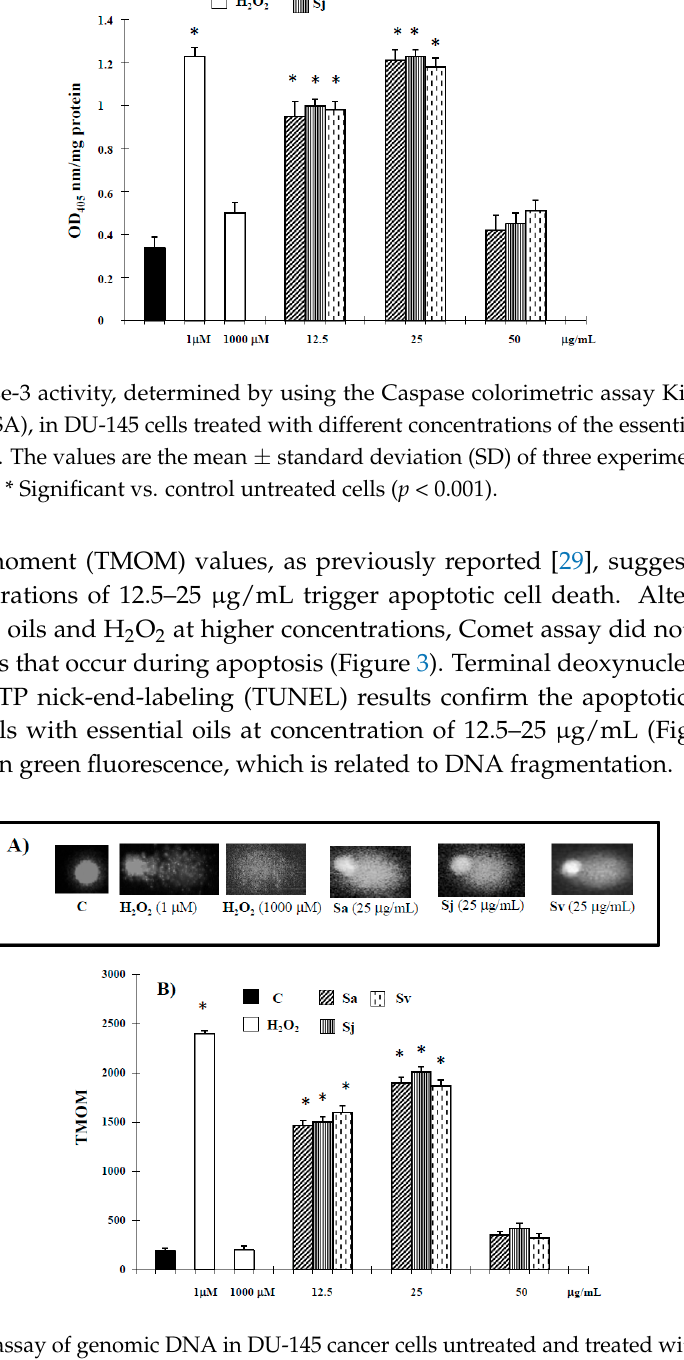
Figure 4. Terminal deoxynucleotidyl transferase (TdT)-mediated dUTP nick-end-labeling (TUNEL) assay in DU-145 cells untreated and treated with different concentrations of the essential oils from Sa, Sj and Sv for 72 h. The values are the mean ± standard deviation (SD) of three experiments performed in quadruplicate. * Significant vs. control untreated cells ( p < 0.001). During the intrinsic apoptosis process, apoptosis-related proteins such as Bcl-2 associated X ( Bax), B-cell lymphoma 2 (Bcl-2), caspase-9 and caspase-3 are modulated for programmed cell death